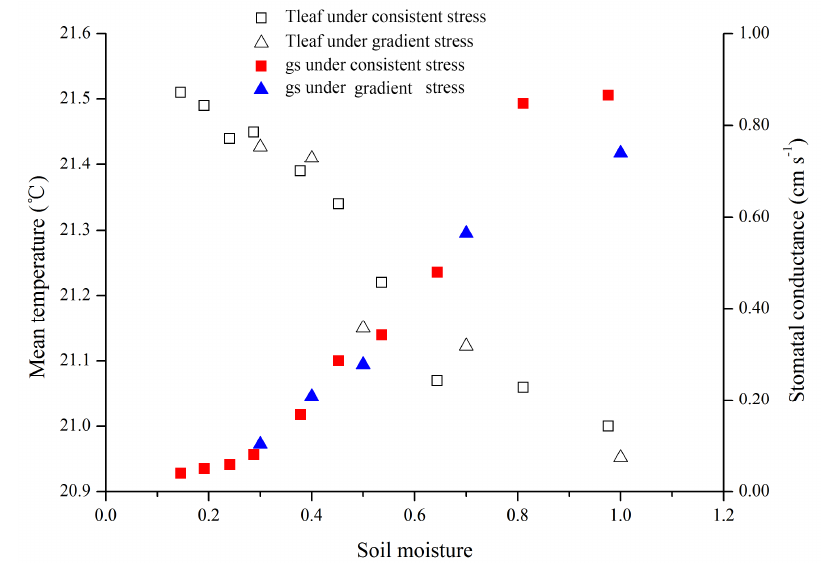
Figure 8. Treatment effects on leaf temperatures ( T leaf ) and stomatal conductance (gs) for consistent and gradient drought